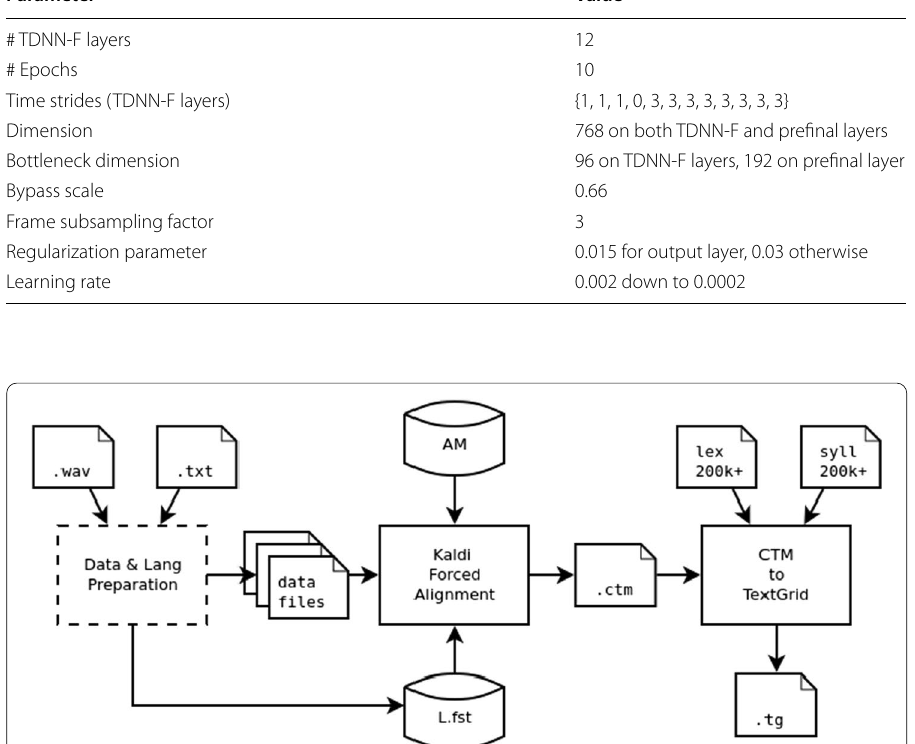
Table 3 Parameters used for TDNN-F training